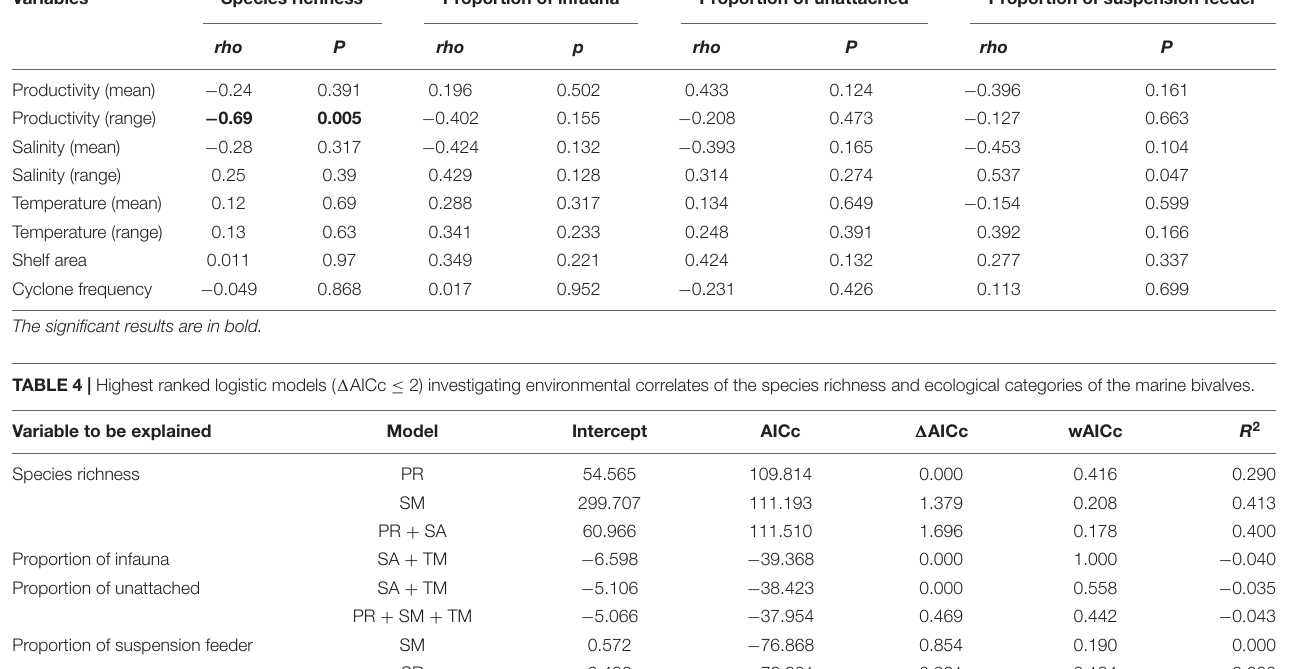
TABLE 3 | Correlation between species richness, proportion of ecological groups with environmental variables for latitudinal bins using Spearmann rank order correlation test. Variables